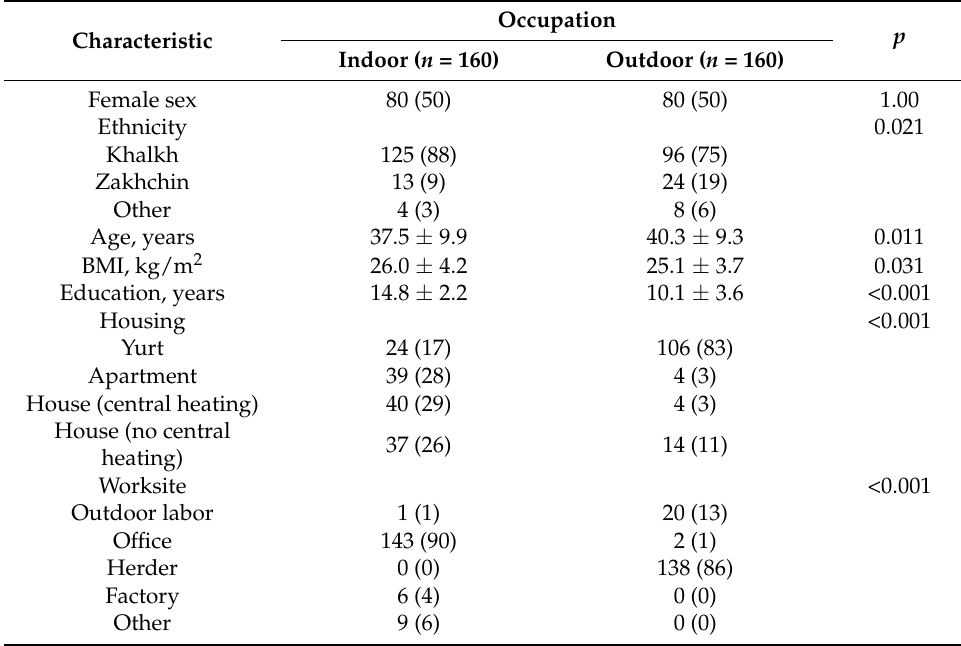
Table 1. Non-seasonal characteristics of study population.